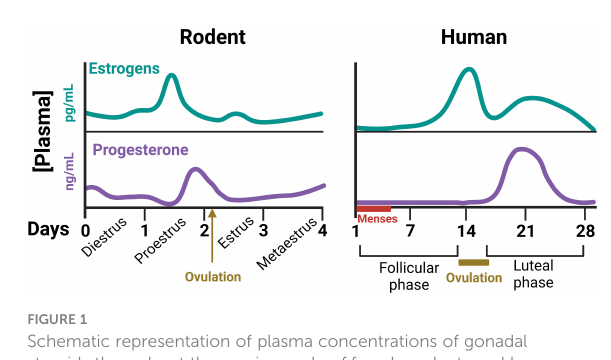
FIGURE 1 Schematic representation of plasma concentrations of gonadal steroids throughout the ovarian cycle of female rodents and humans (11, 12). These cyclic changes of ovarian hormones not only control the development of the ovarian follicles, but many other body functions, including thermal homeostasis.